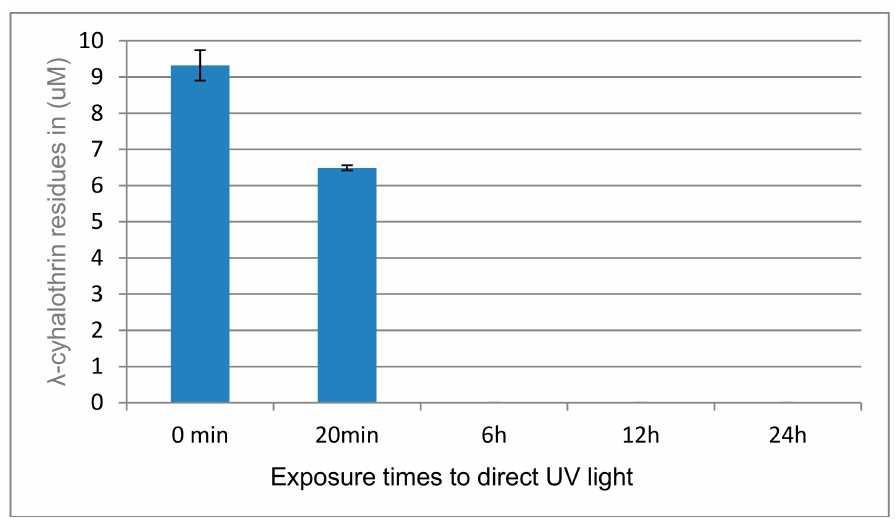
Figure 7. Quantification of λ -cyhalothrin residues at various time exposures to direct UV light.